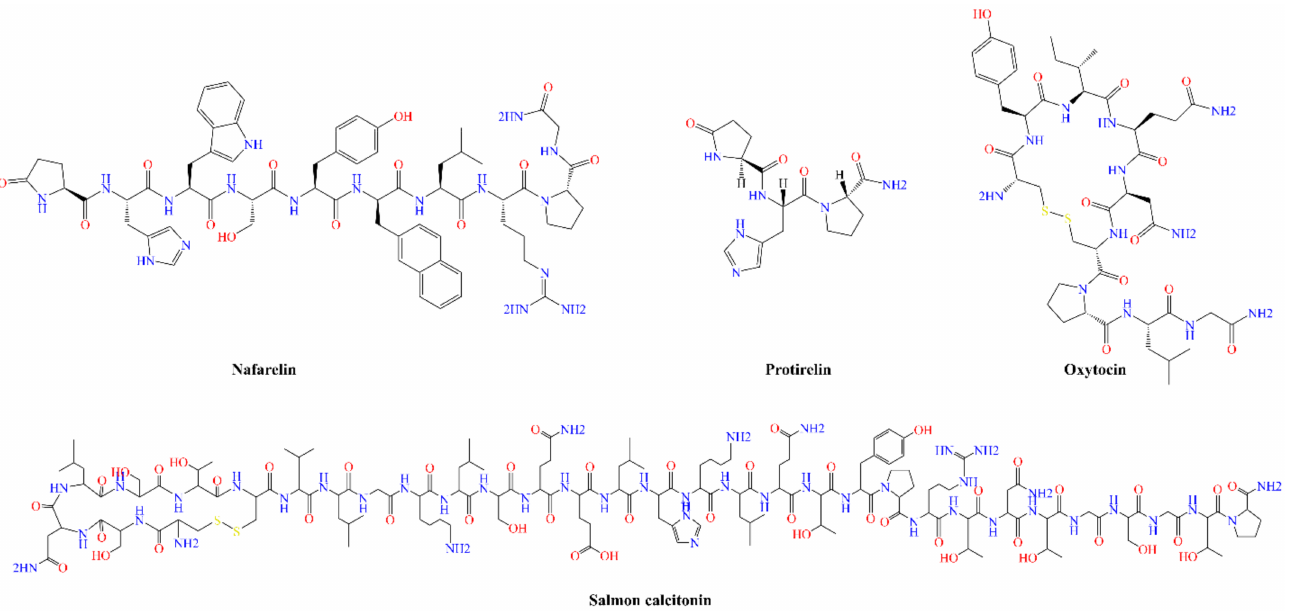
Figure 2. Chemical structures (drawn using CambridgeSoft™, Cambridge, MA, USA) of example peptides used in nasal delivery